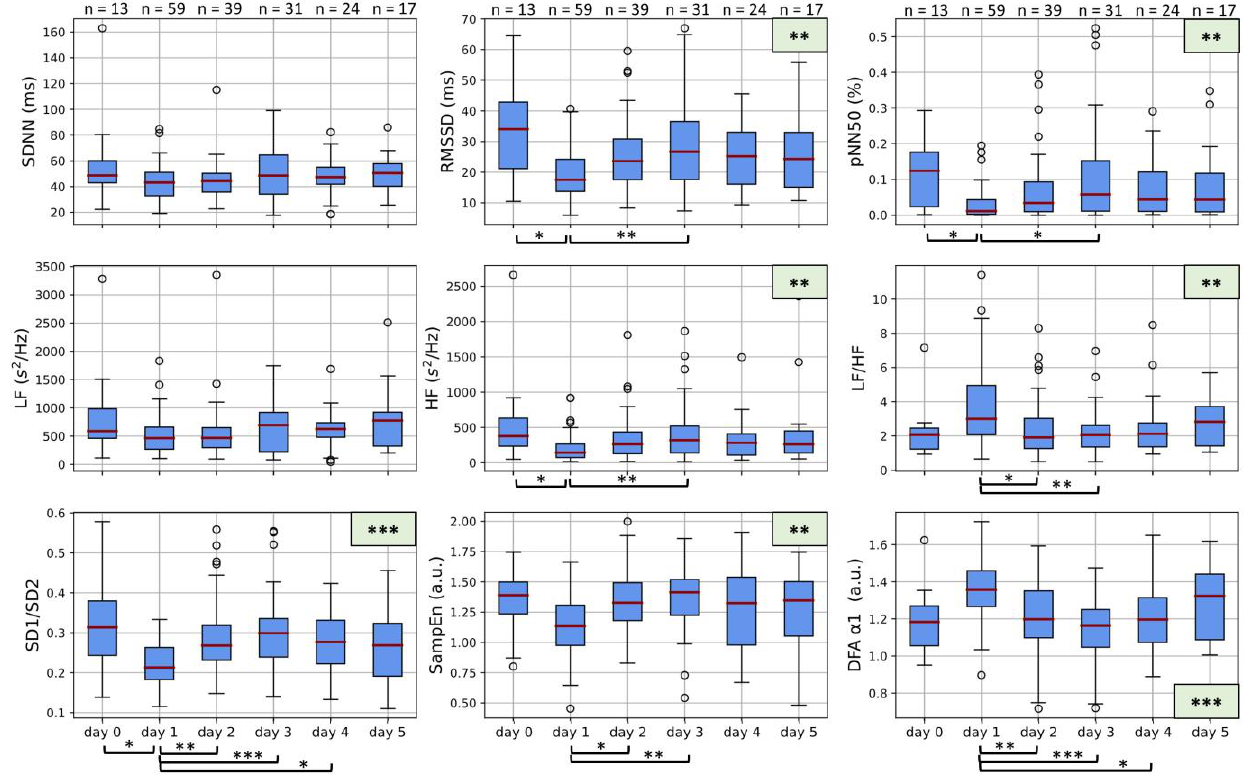
Figure 2. Boxplots of maternal HRV on days 0 to 5 . Boxplots represent the median, interquartile range, and interdecile range of the values. Day 0 represents measurements taken before the first injection of Betamethasone, while day 1 represents 24 h after the first injection, day 2 represents 48 h after the first injection, etc. * represents a statistically significant finding with p < 0.05, while ** presents p < 0.01 and *** represents p < 0.001. The number of measurements incorporated into each day is displayed at the top of the graph.